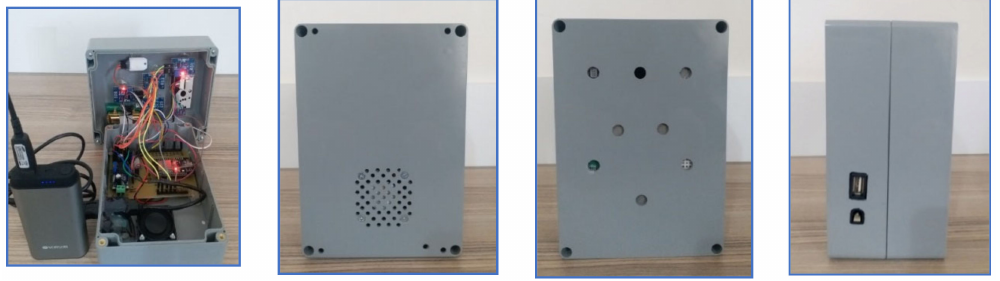
Figure 2. Images of the IoT-based e-nose